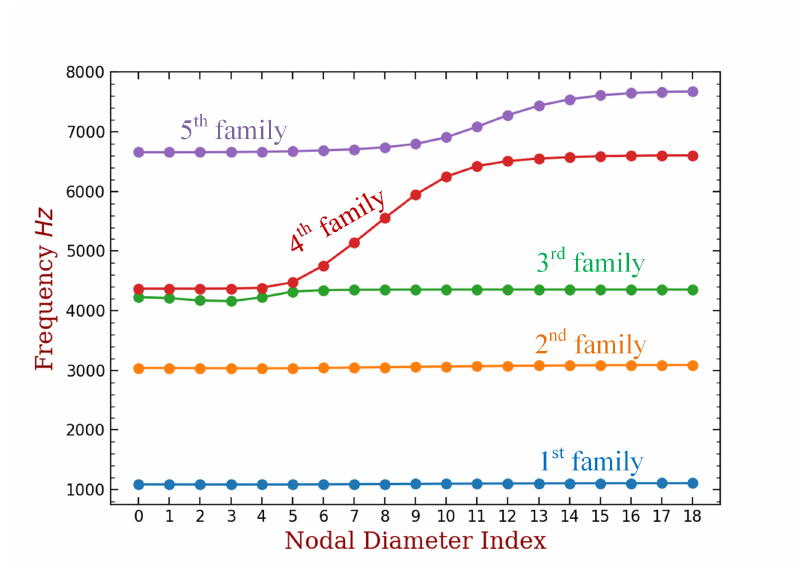
Figure 2. Natural frequencies of the bladed disk, sorted by nodal diameter index (NDI).